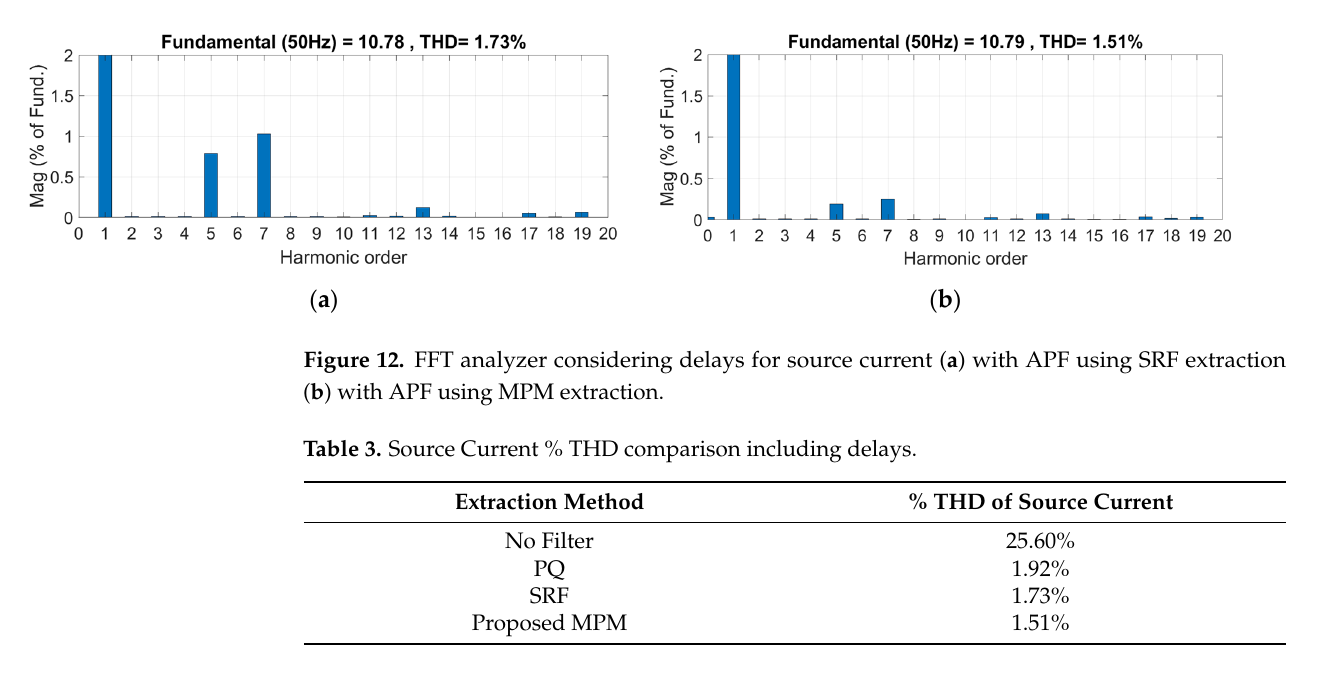
Table 4. Source Current % THD comparison under asymmetrical load